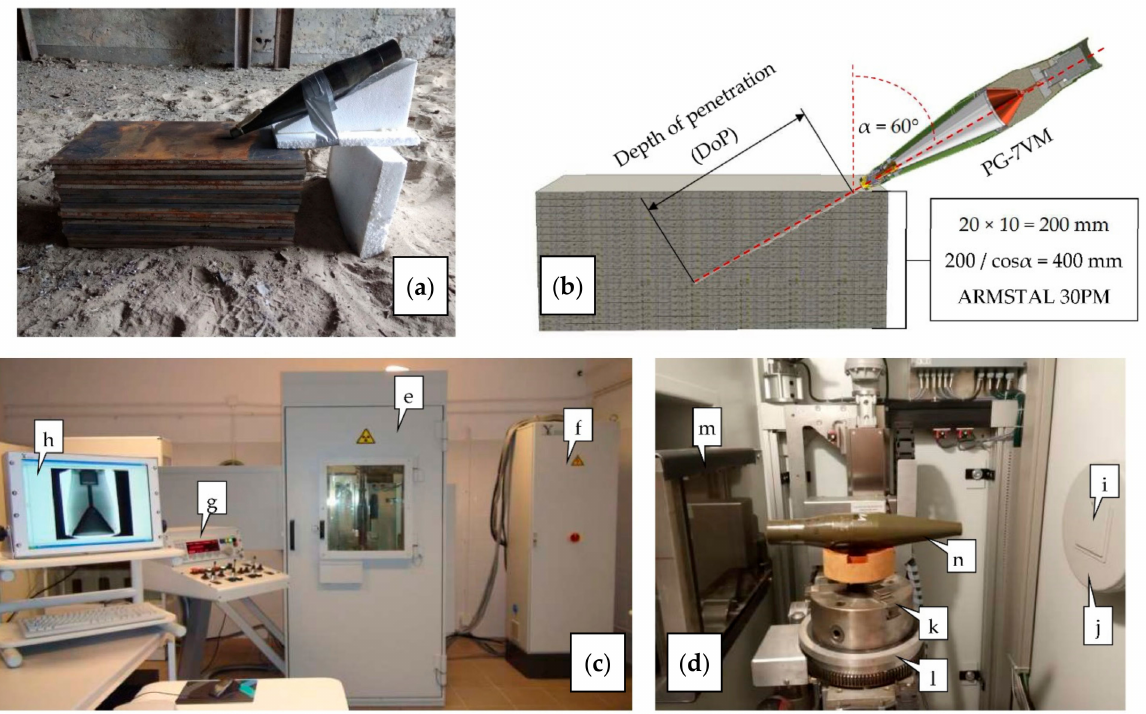
Figure 1. Experimental test setup: ( a ) real setup of DoP tests; ( b ) schematic setup of DoP tests with some geometrical and material data; ( c ) X-ray Diagnostic System MU17F 225-9 (by YXLON International GmbH, Hamburg, Germany) used for the inspection of PG-7VM warheads; ( d ) interior of the radiation cabin; ( e ) radiation cabin with the HDR detector and the X-ray tube inside; ( f ) power supply device; ( g ) control panel with a joystick; ( h ) monitor with a real-time view of the warhead; ( i ) adjustable shutter; ( j ) X-ray lamp; ( k ) three-jaw chuck; ( l ) turning table; ( m ) flat panel detector; ( n ) inspected PG-7VM